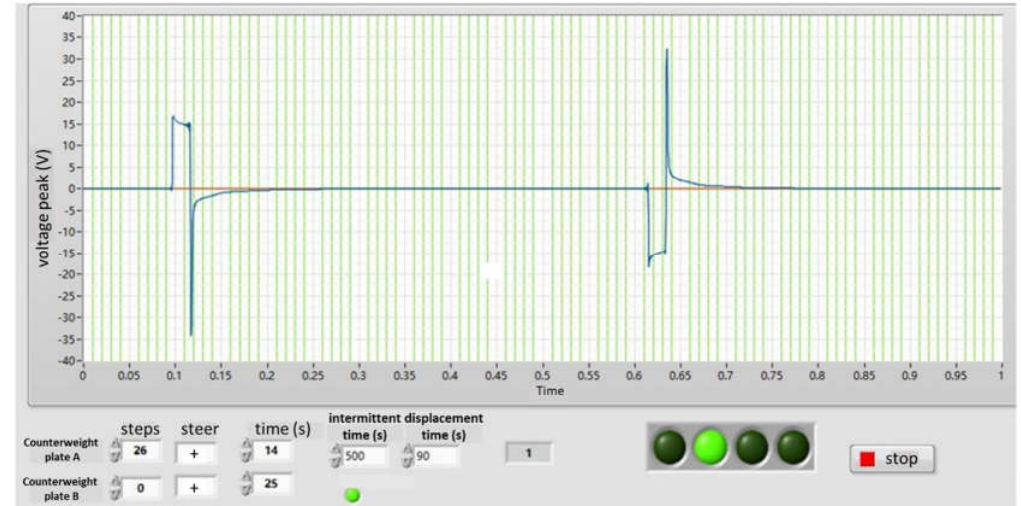
Figure 17. Control program of Step rotation experiments.